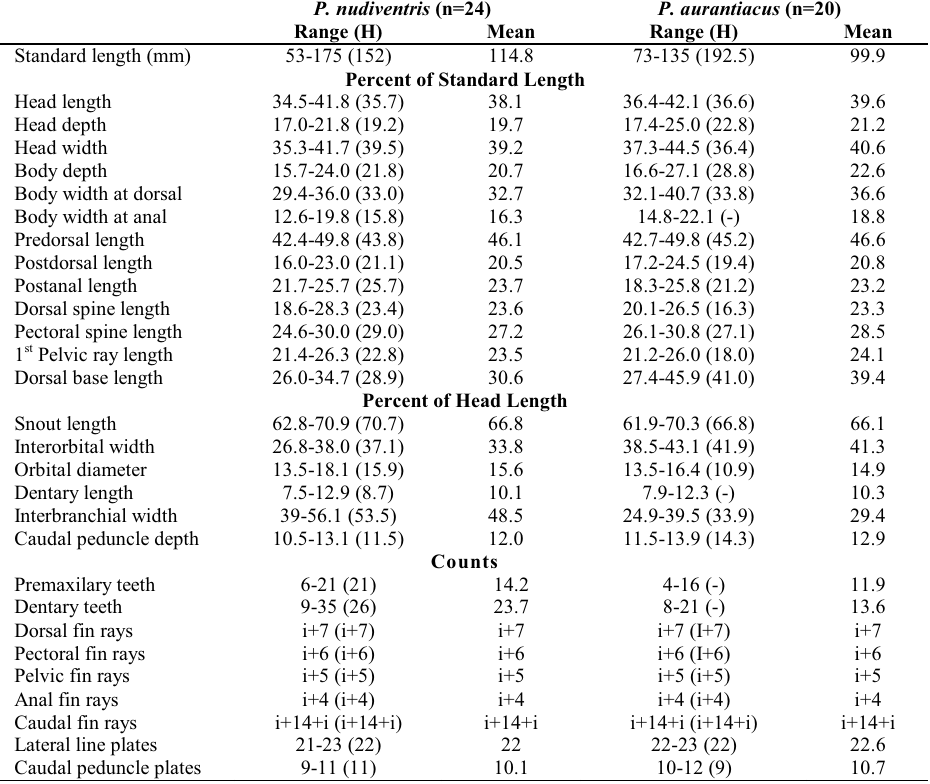
Table 1 . Counts and morphometrics of Parancistrus nudiventris and P. aurantiacus (H = holotype). Holotype of P. aurantiacus is a deformed, stuffed specimen, so data not included in